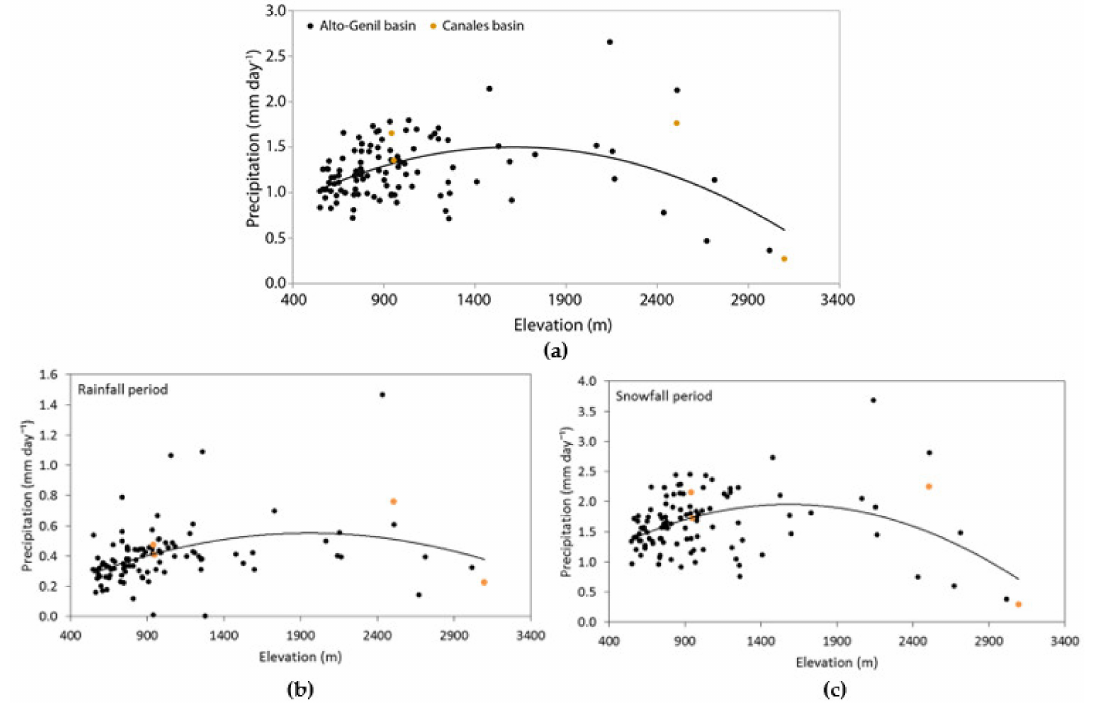
Figure 4. ( a ) Mean daily precipitation data depending on elevation in the Alto Genil basin, where the Canales basin is located. Trend of precipitation with elevation for ( b ) the snowfall and ( c ) rainfall period. Orange dots represent gauges included in the Canales basin.